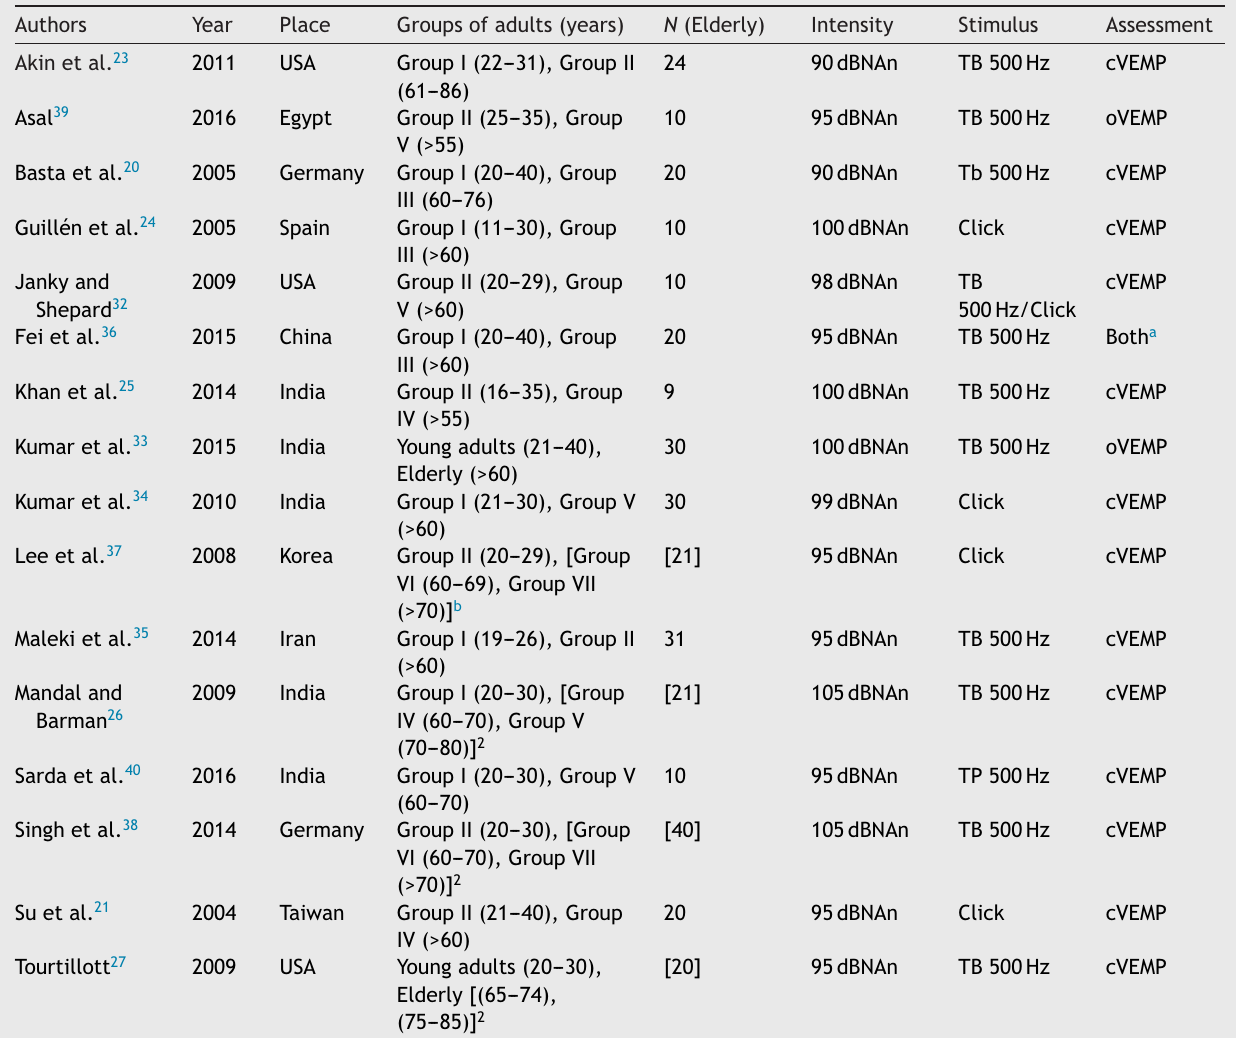
Characteristics of included